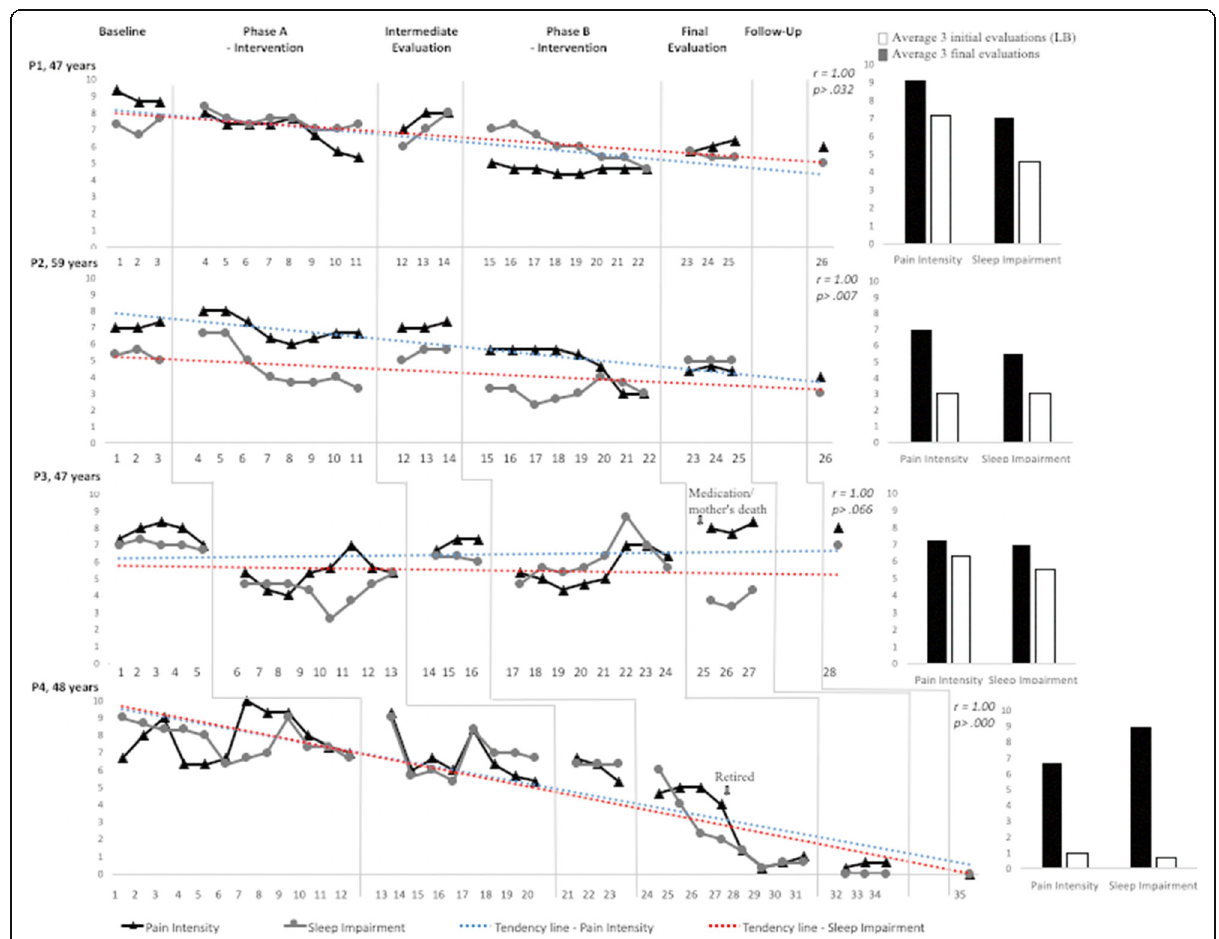
Fig. 2 Mean of every three records of pain intensity and impairment in sleep quality (line charts). The vertical lines indicate changes in the intervention conditions. Mean of the first three and three last records of pain intensity and impairment in sleep quality (spinal